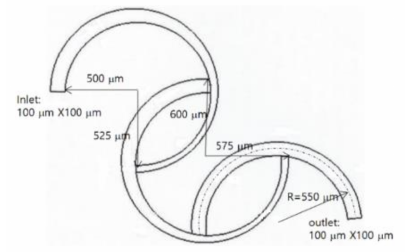
Figure 5. Diagram of the SAR examined by Sheu et al.